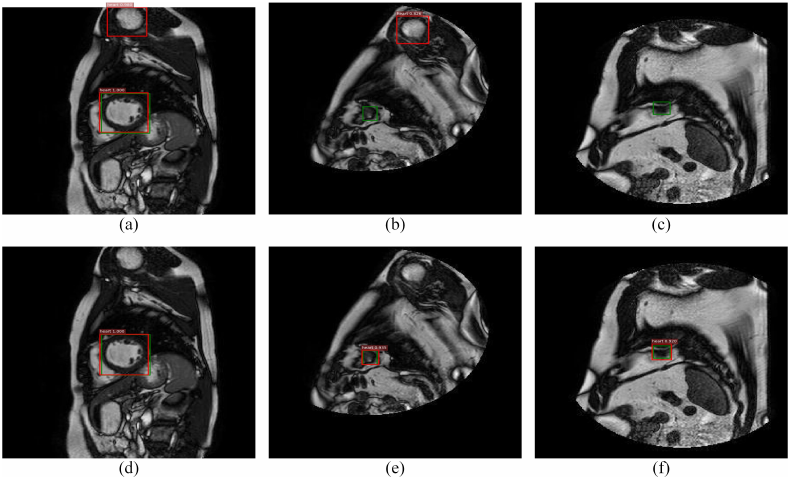
Figure 1. Detection examples of hard false positives and hard false negatives samples, where the first row ( a – c ) and the second row ( d – f ) are the results of Faster RCNN and the proposed method, where red and green denotes the detection rectangle and the ground truth in each image, respectively. It is seen that pseudo or small left ventricles easily lead to